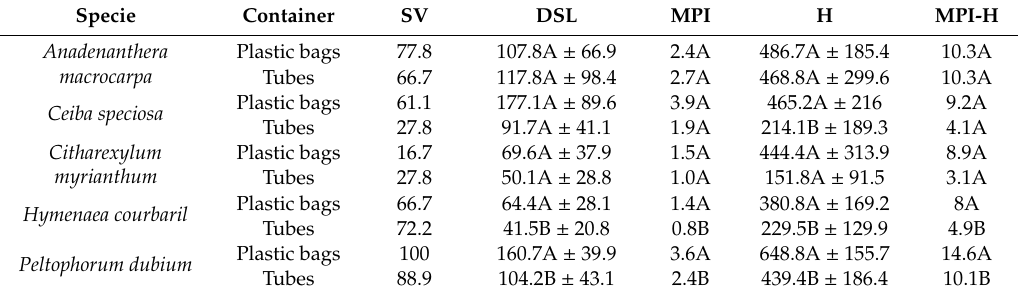
Table 4. Percentage of survival (SV), average diameter at soil level in mm (DSL), monthly periodic increments of DSL in mm month − 1 (MPI), average height in cm (H) and MPI of H in cm month − 1 (MPI-H) at 42 months after planting. Means with di ff erent letters between containers for each species are statistically di ff erent at 95% probability, determined by the Tukey test. ± standard deviation of the mean ( n =